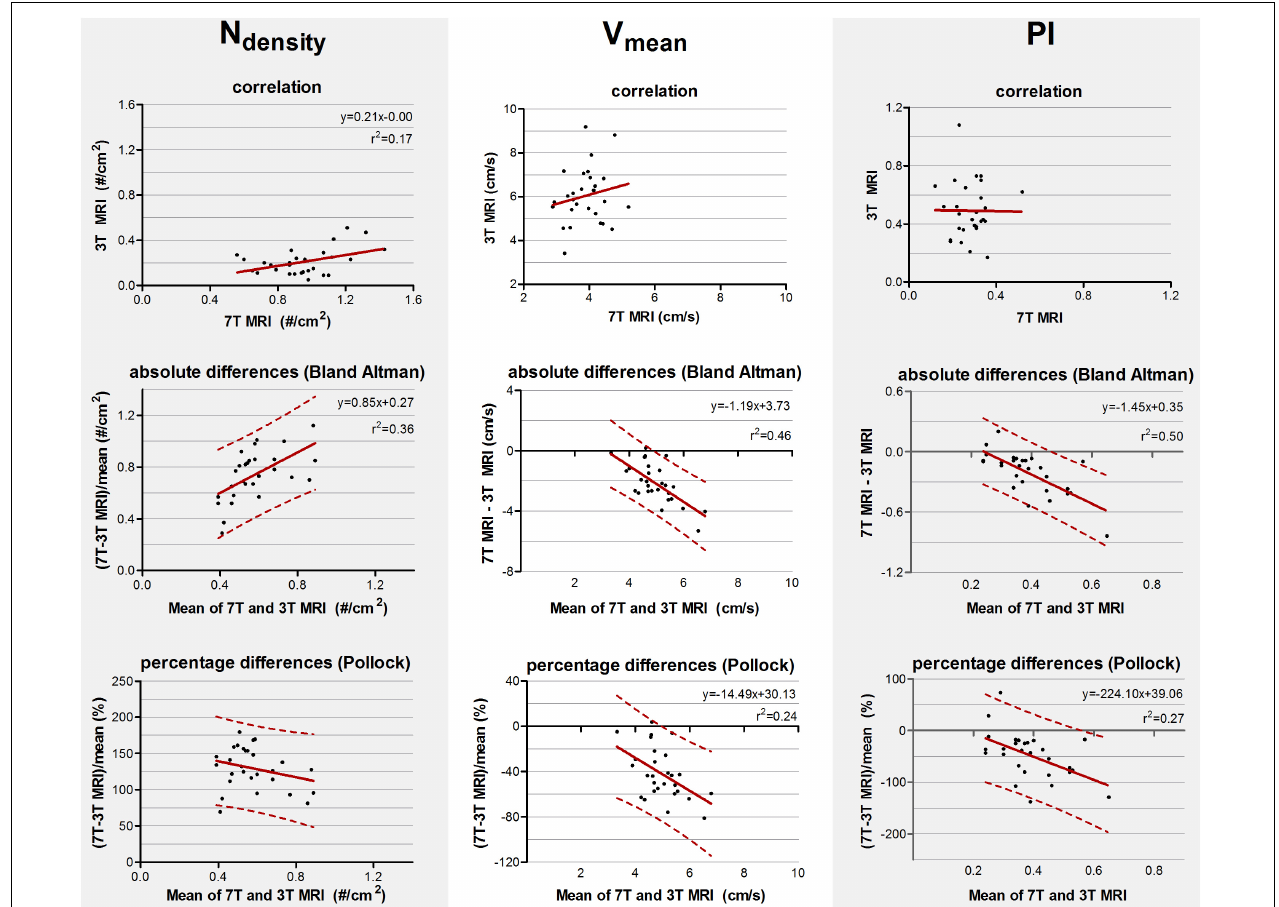
FIGURE 3 | Top row: Correlation plots of the number of detected perforating arteries/cm 2 (N density ), the mean blood flow velocity (V mean ) and pulsatility (PI) measured at 3 tesla (T) and 7T MRI. The line resulting from linear regression is given by the solid line. In case of a significant correlation the equation of the regression line is given. Middle and bottom row: difference plots in absolute units (Bland Altman) and in percentage units (Pollock), respectively, for N density , V mean , and PI. The regression line (i.e., bias) (solid line) and the limits of agreement (dotted lines) are shown. In case of a significant linear regression, the equation of the regression line is